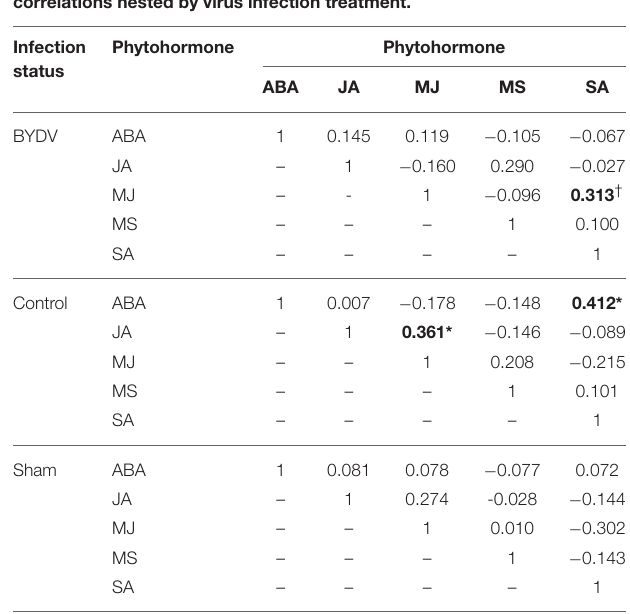
TABLE 2 | Correlation coefficients ( r ) for pairwise comparisons of concentrations (mg/g) of five phytohormones in wheat leaf tissues, with correlations nested by virus infection treatment.